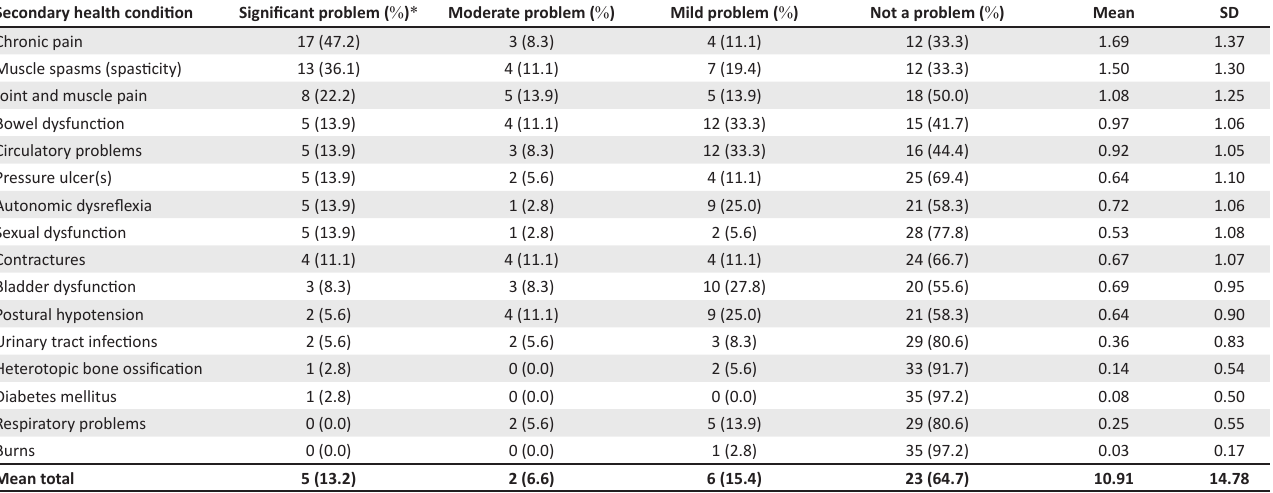
TABLE 3: Secondary health conditions experienced by people with spinal cord injury as well as the descriptive statistics of the Spinal Cord Injury Secondary Conditions Scale ( n =